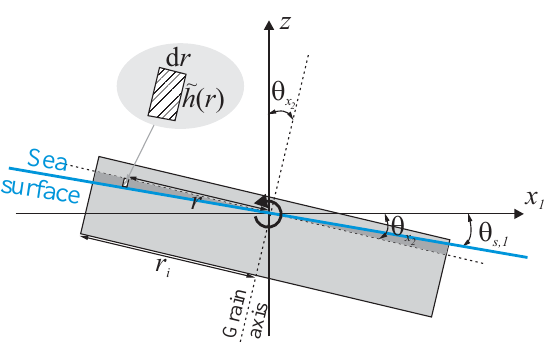
Figure 4. A sketch of a circular grain on a sloping sea surface, il- lustrating the variables involved in calculation of the wave-induced torque (see text for